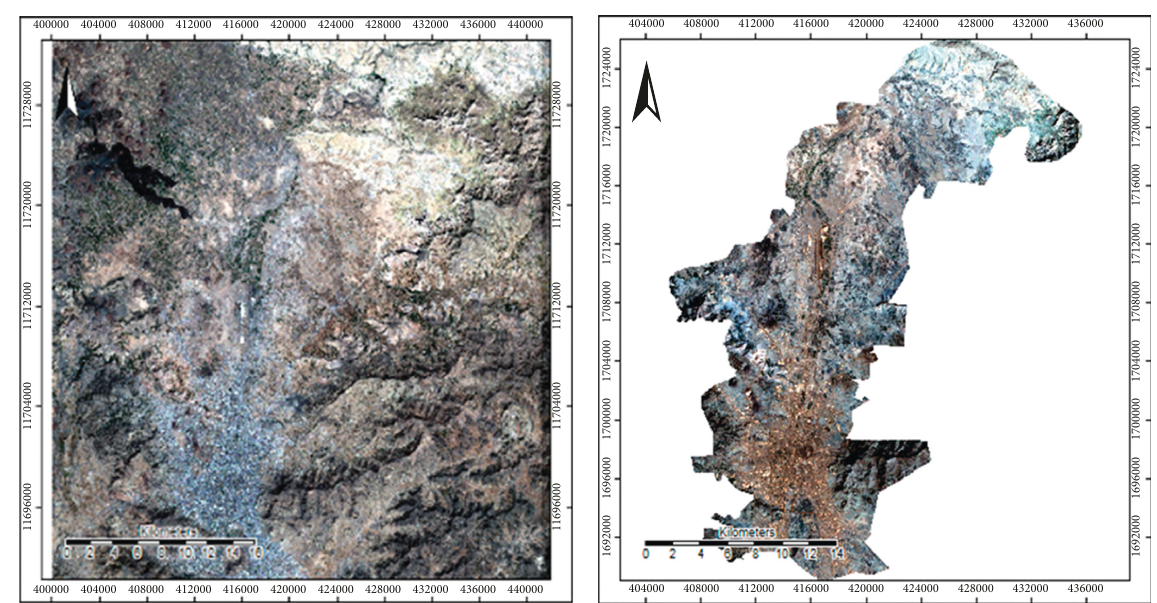
Figure 4: Selection of dataset from Sentinel-2A satellite and clipping of area study.